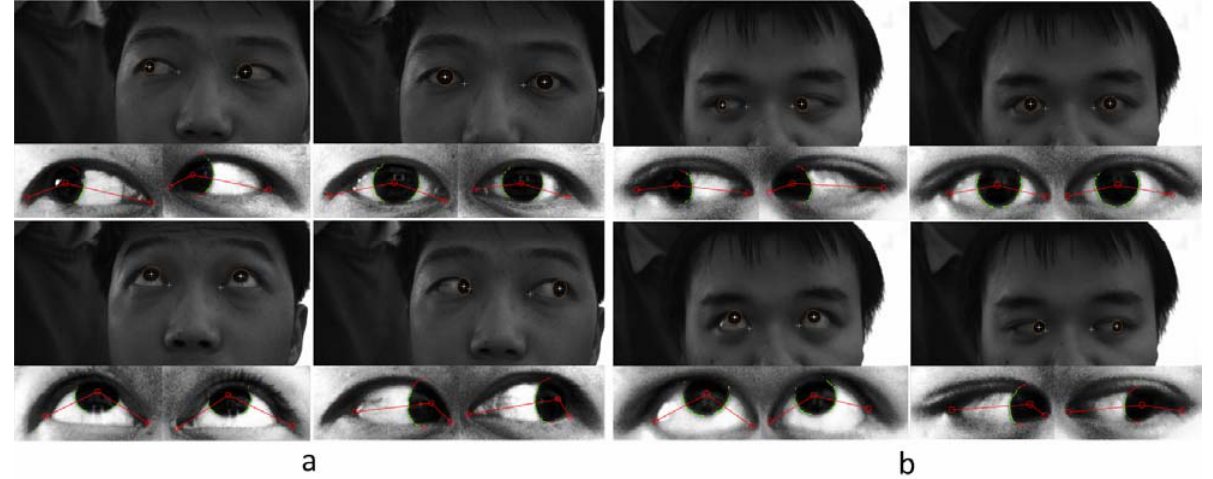
Figure 21: Estimated eye gaze for the four target points: , , , and . (a) Subject #3, (b) Subject #7.